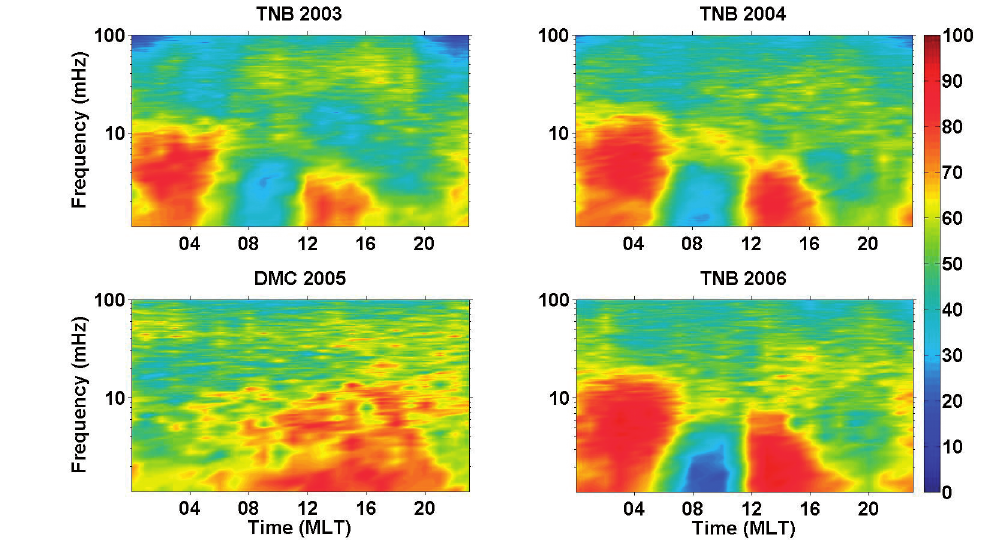
Fig. 4. MLT and frequency distribution of the percentage of CW events at TNB and DMC